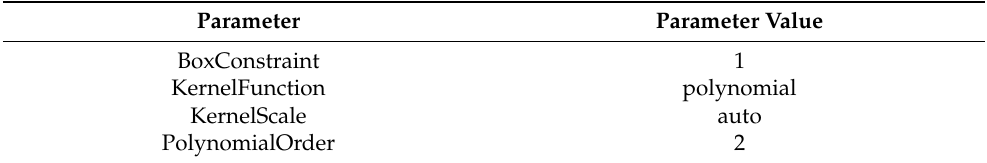
Table 3. Support vector machine parameter